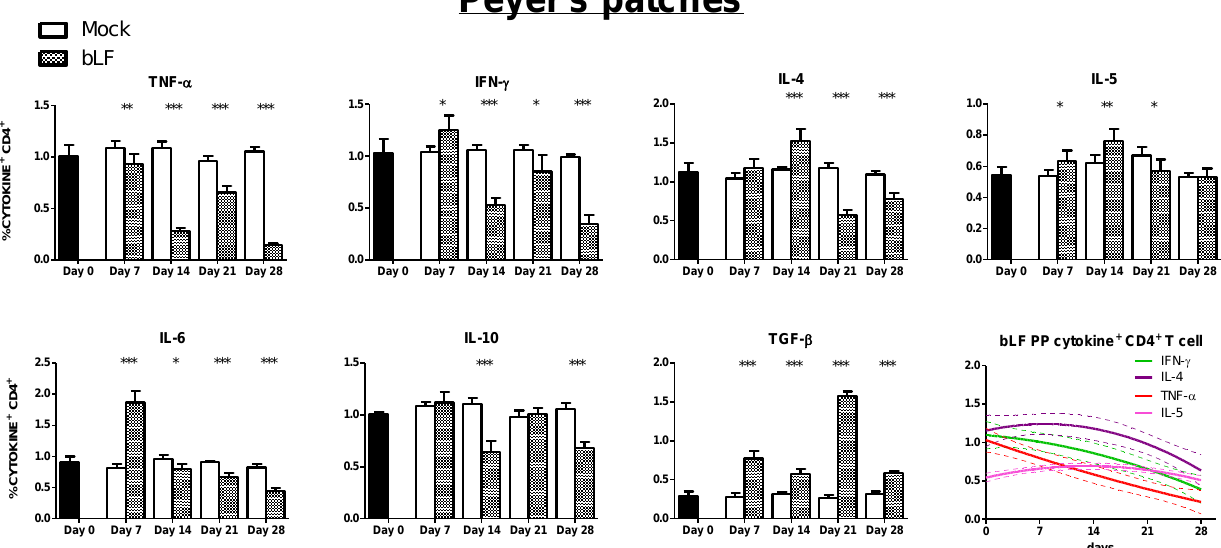
Figure 3. Effects of oral bLf vs. mock on the percentages of cytokine + CD4 + T cells in PP of the proximal small intestine. Mean and SD are shown. Non-linear regression models were plotted for TNF- α , IFN- γ , IL-4 and IL-5. Significant differences: * p ≤ 0.05, ** p ≤ 0.01, *** p ≤ 0.001 compared to mock. Non-significant results are omitted.